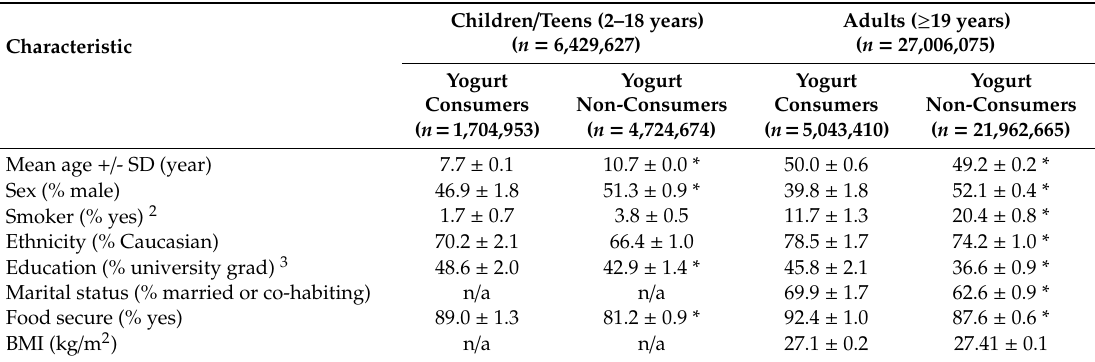
Table 1. Sociodemographic characteristics of Canadians children and adults among yogurt consumers and non-consumers 1